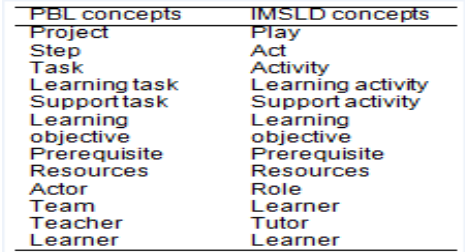
Table 1. Pedagogical model